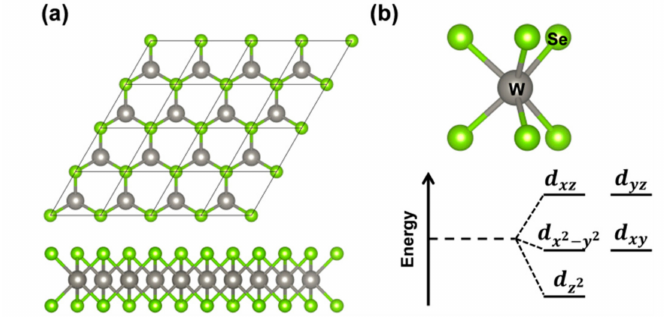
Figure 1. ( a ) Top and side views of a repeated unit cell of 2D tungsten diselenide (2D-WSe 2 ); ( b ) A view of the trigonal prismatic coordination and a scheme of the d states splitting in WSe 2 monolayer deriving from